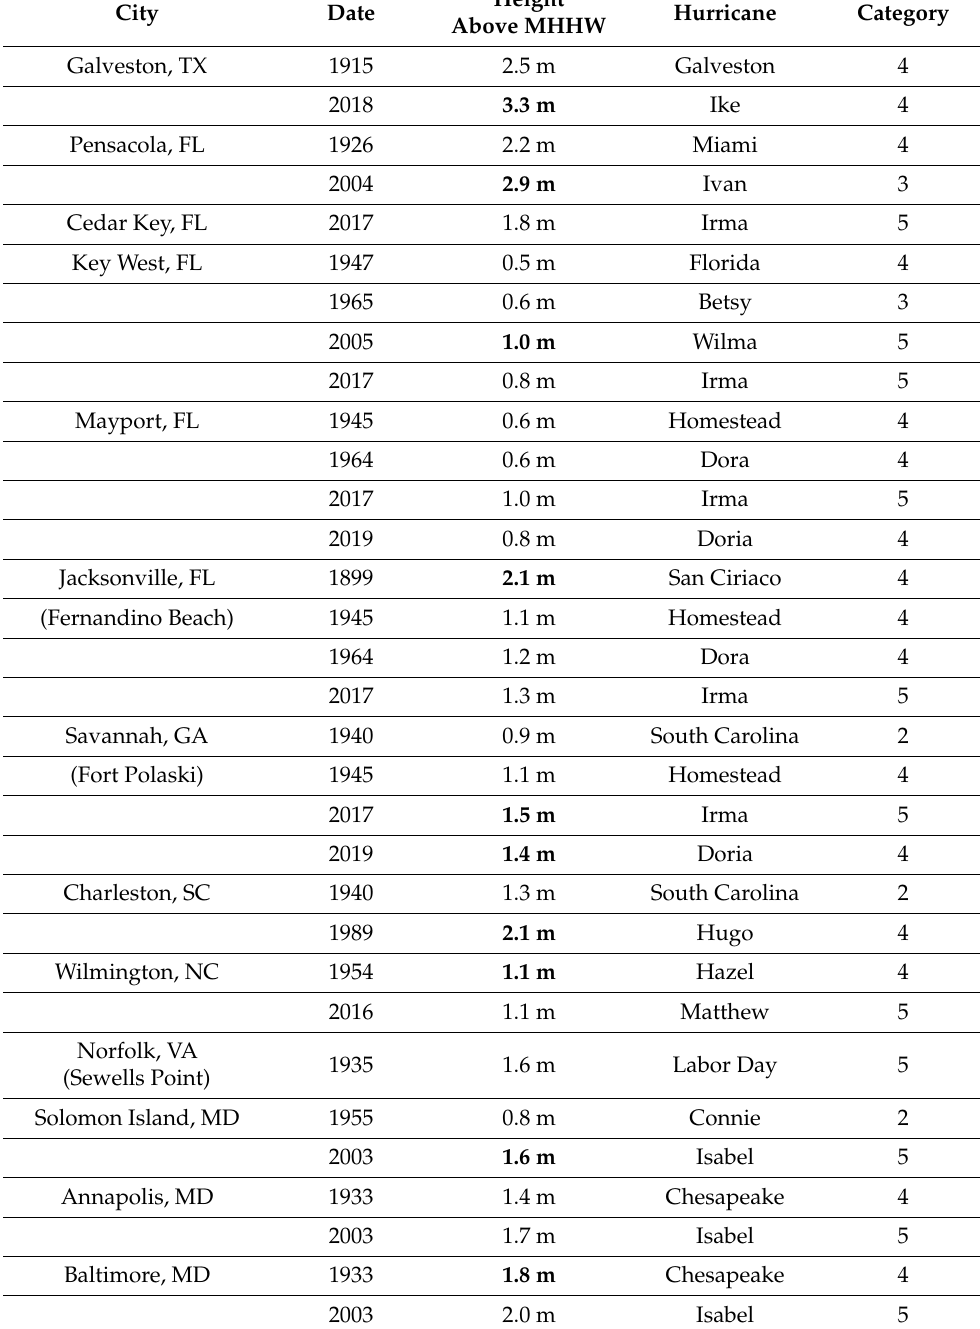
Table 1. Recorded 1/100 year storms by tidal